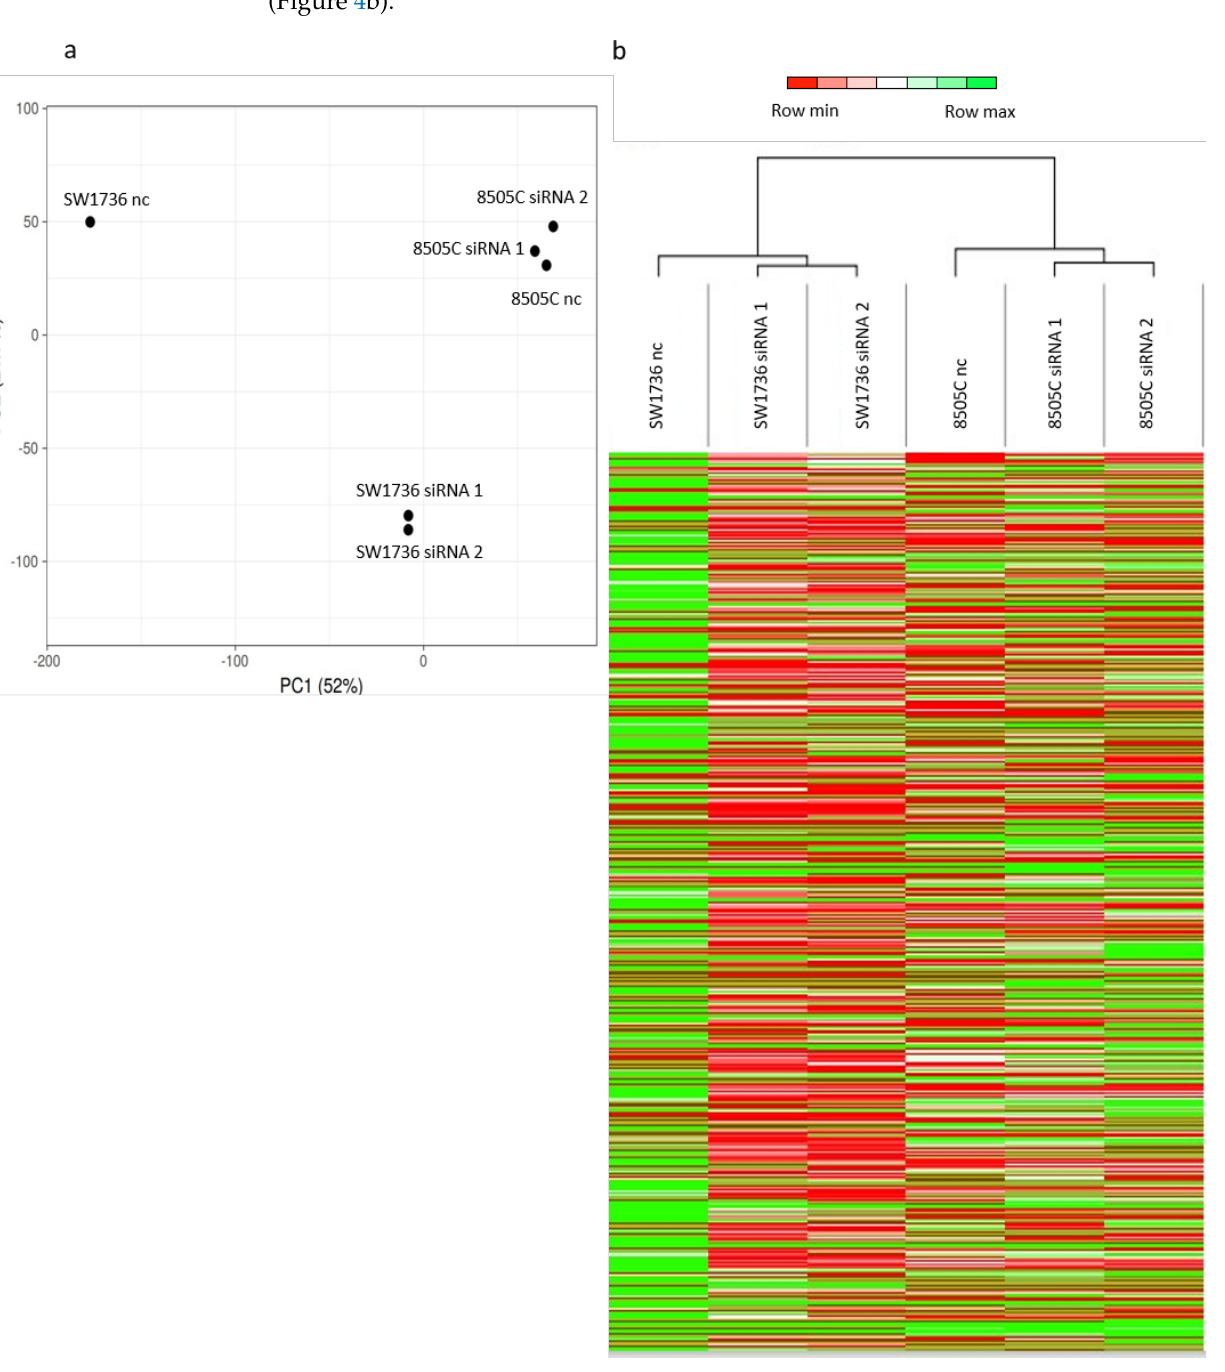
Figure 4. Gene expression analysis after METTL3 silencing in ATC cells. ( a ) Principal component analysis (PCA) results. Each point represents an RNA-seq sample. Samples with similar gene expression profiles are clustered together. ( b ) Heat maps showing the hierarchical clustering of RNAs in untreated cells (SW1736 nc/8505C nc) and in METTL3 siRNA-treated ones (SW1736 siRNA 1/8505C siRNA 1 and SW1736 siRNA 2/8505C siRNA 2) and 8505C. Results are shown as fold change (log